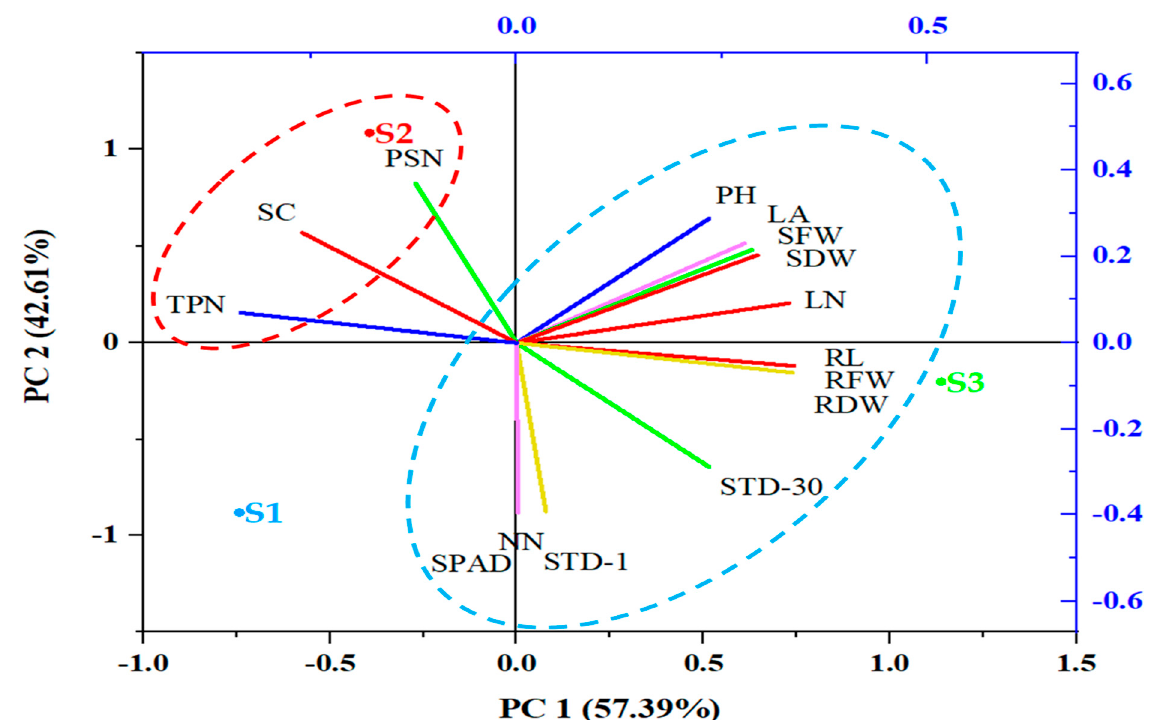
Figure 4. Principal component analysis (PCA) illustrates the variable treatment relationships among the three treatments of M-9 apple rootstock plant at 11 weeks after in a greenhouse. S1, S2 and S3 indicate 1:1:1, 1:2:3, and 3:1:2 ratio of peat moss: vermiculite: perlite, respectively. The lines starting from the central point of the biplots display the negative or positive associations of the different variables, and their proximity specifies the degree of correlation with specific treatment. PH, plant height; LN, leaf number; LA, leaf area; NN, node number; RL, root length; STD-1, stem diameter from 1 cm of ground; STD-30, stem diameter from 30 cm of ground; SFW, shoot fresh weight; RFW, root fresh weight; SDW, shoot dry weight; RDW, root dry weight; SPAD, SPAD value; PSN, photosynthesis rate; SC, stomatal conductance and TPN, transpiration rate.